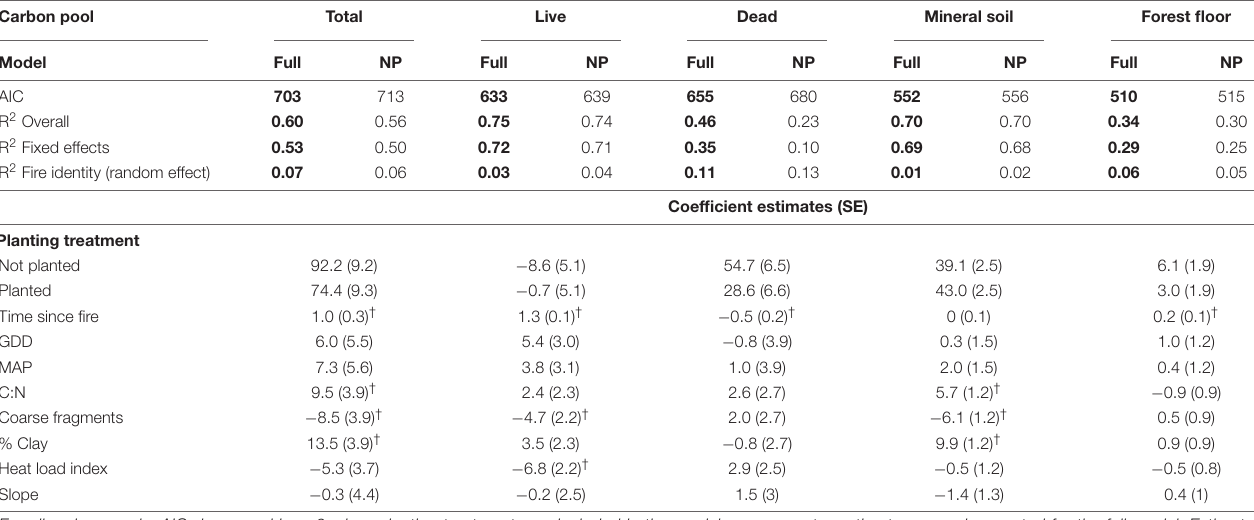
TABLE 1 | Model parameter estimates (SE) and model fit (AIC, R 2 ) for each carbon pool, where † denotes an important predictor covariate ( p < 0.05). Carbon